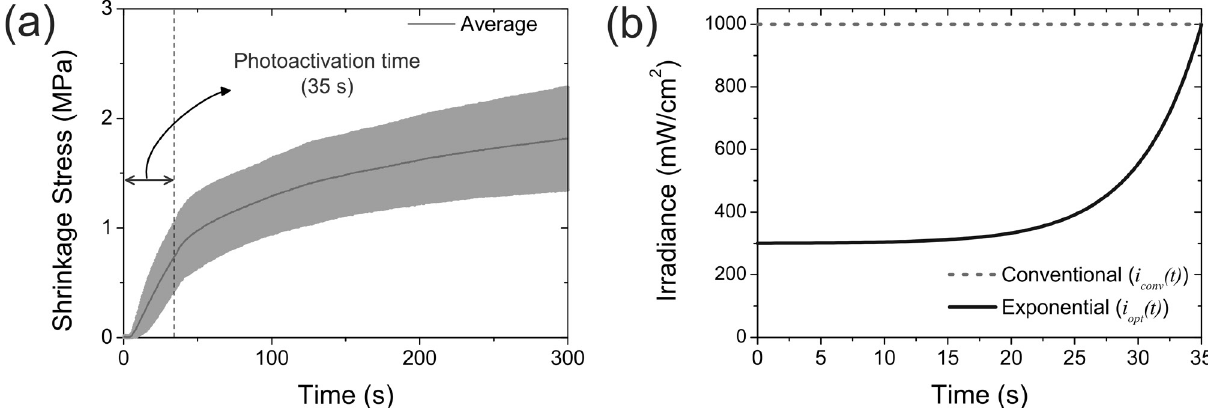
Figure 1- Illustration of: (a) shrinkage stress at the time domain for the conventional photoactivation method; (b) the conventional method of photoactivation and theoretical optimized curve to minimize the effects of the polymerization